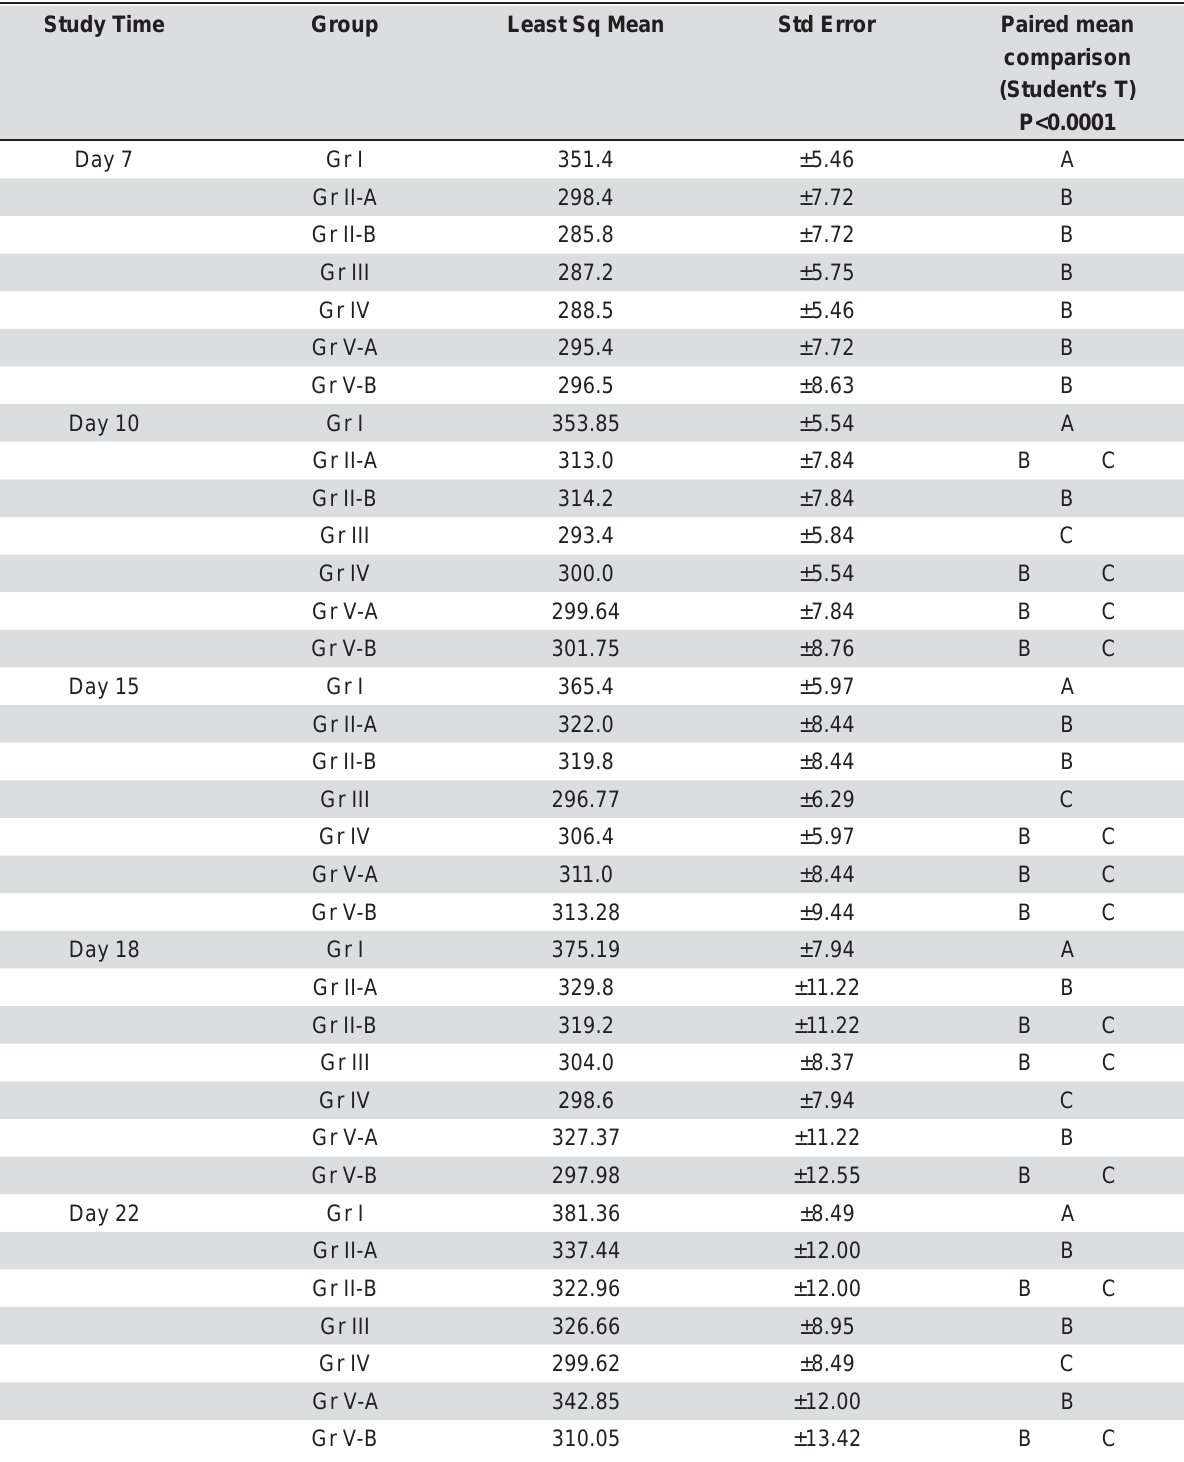
Table 1- Statistical results with mean values±SE of the animal weights of the various experimental groups over study